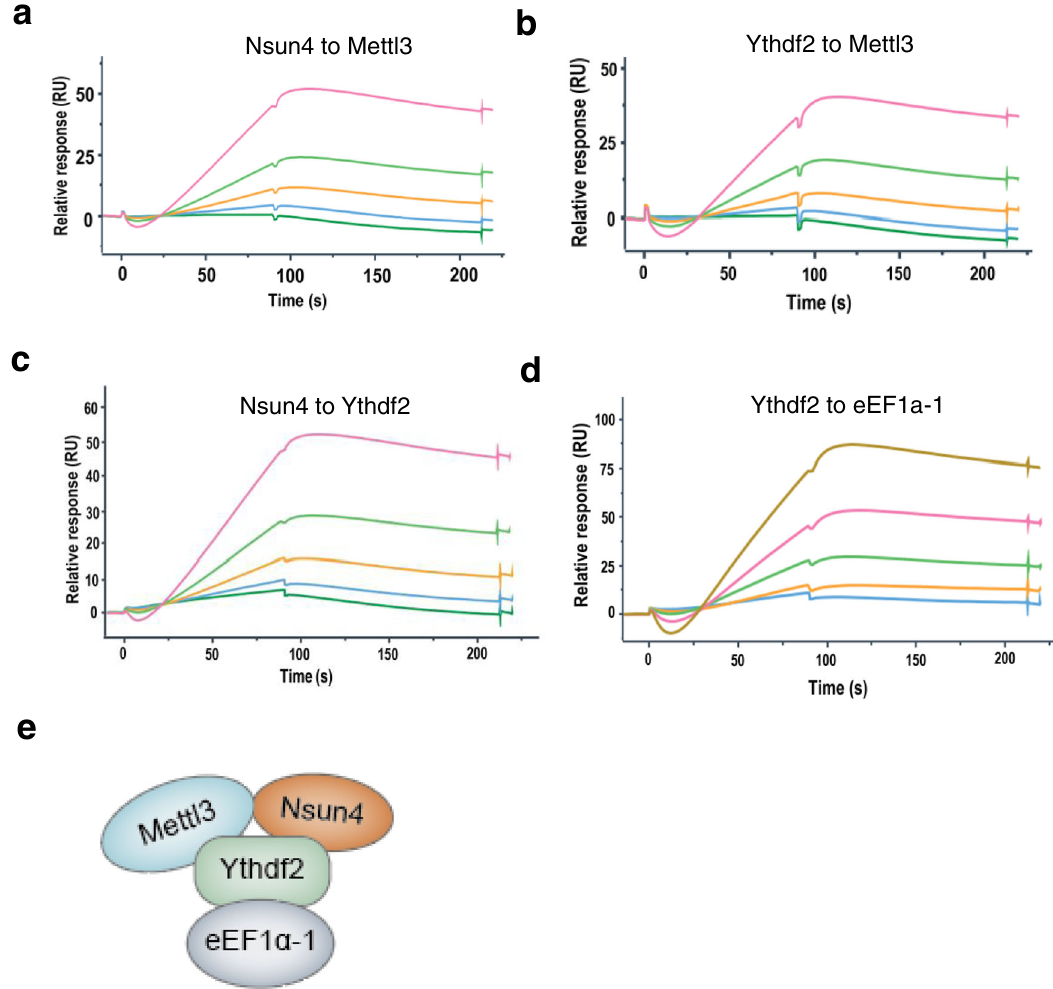
Fig. 5 The assembly model of NMYE complex is con fi rmed in vitro. a , b SPR sensorgram showing the binding of Mettl3 with Nsun4 ( a ) and Ythdf2 ( b ), respectively. c , d SPR sensorgram showing the binding of Ythdf2 with Nsun4 ( c ) and eEF1 α -1 ( d ), respectively. Data are shown as black lines and the fi tted lines in red. e A cartoon depicting the interaction mode of the NMYE